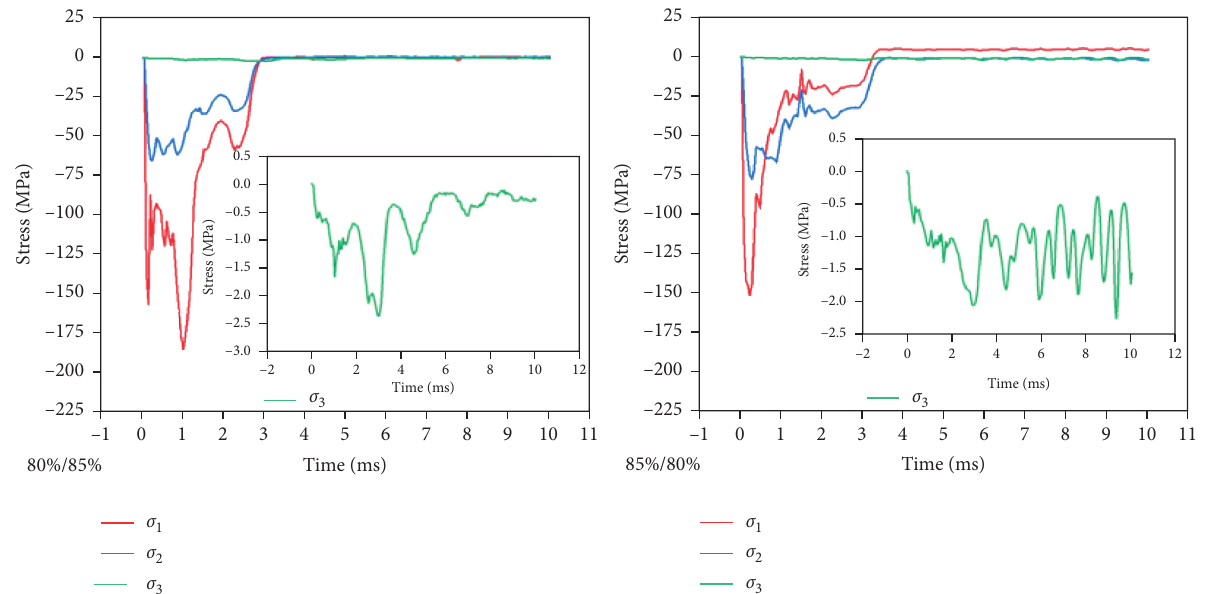
Figure 14: Double-layer aluminum foam with porosity of 80% and